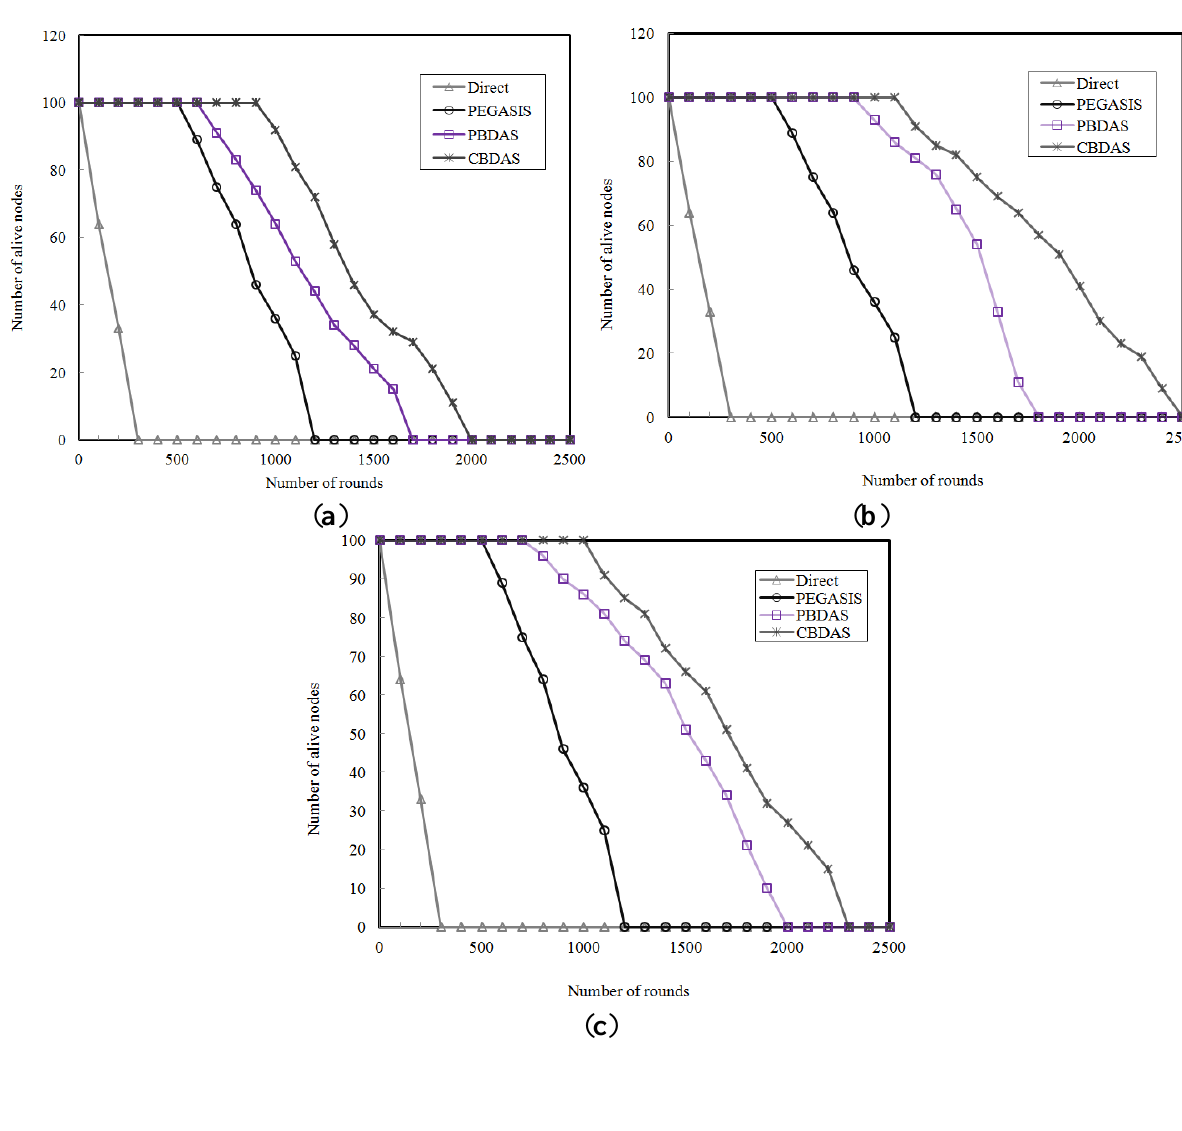
Figure 8. Number of alive nodes over time. ( a ) A grid of 6 × 6 cells; ( b ) A grid of 8 × 8 cells; ( c ) A grid of 10 × 10